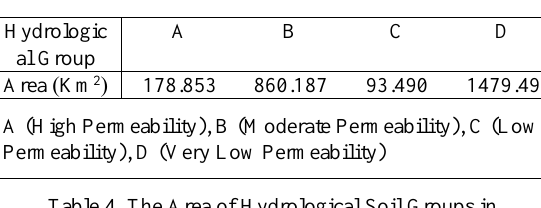
Table 4. The Area of Hydrological Soil Groups